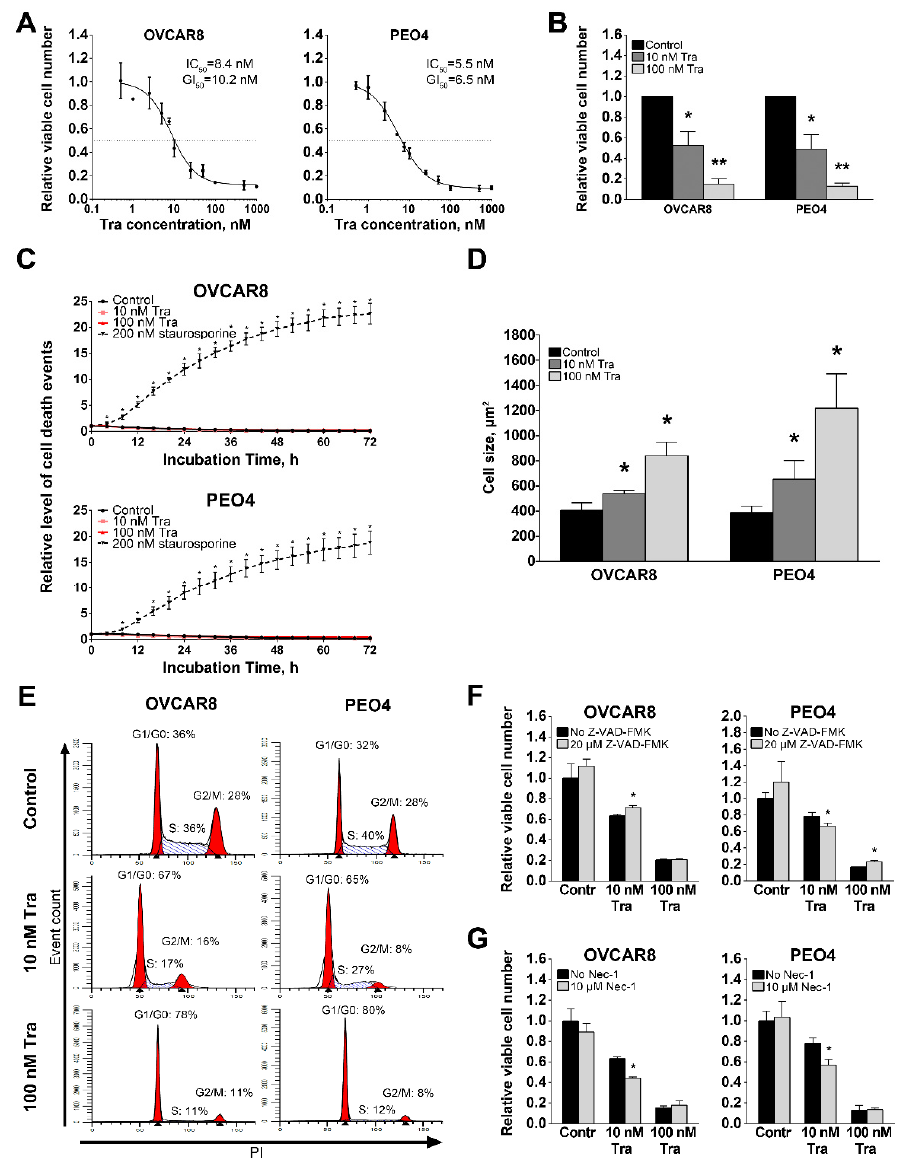
Figure 4. Changes in functional characteristics of HGSOC cell cultures caused by trametinib treatment. ( A ) Dose-response curves generated using relative viable cell numbers after treatment with various concentrations of trametinib for 72 h. Data are normalized to vehicle-treated control samples (not shown) and presented as mean ± S.D. ( n = 3). ( B ) Viable cell numbers after treatment with selected concentrations of trametinib for 72 h. Data are normalized to “Control” samples and presented as mean + S.D. ( n = 6, Mann-Whitney U-test, * - p < 0.05, ** - p < 0.01). ( C ) Cytotoxic effect of trametinib treatment detected using the CytoTox reagent. Staurosporin is used as a positive control. Fluorescence level for each time point is normalized to the area covered by cells and starting value; data are presented as mean ± S.D. ( n = 4, Mann-Whitney U-test, * - p < 0.05). ( D ) Average cell size after treatment with trametinib for 72 h. Data are presented as mean + S.D. ( n = 4, Mann-Whitney U-test, * - p < 0.05). ( E ) Cell cycle phase analysis after trametinib treatment for 24 h. ( F ) Effect of pan-caspase inhibitor Z-VAD-FMK on cells treated with trametinib for 72 h. Data are normalized to “Control, No Z-VAD-FMK” sample and presented as mean + S.D. ( n = 4, Mann-Whitney U-test, * - p < 0.05). ( G ) Effect of the RIPK1 inhibitor necrostatin-1 on cells treated with trametinib for 72 h. Data are normalized to “Control, No Nec-1” sample and presented as mean + S.D. ( n = 6, Mann-Whitney U-test, * - p < 0.05). Tra—trametinib, PI—propidium iodide,